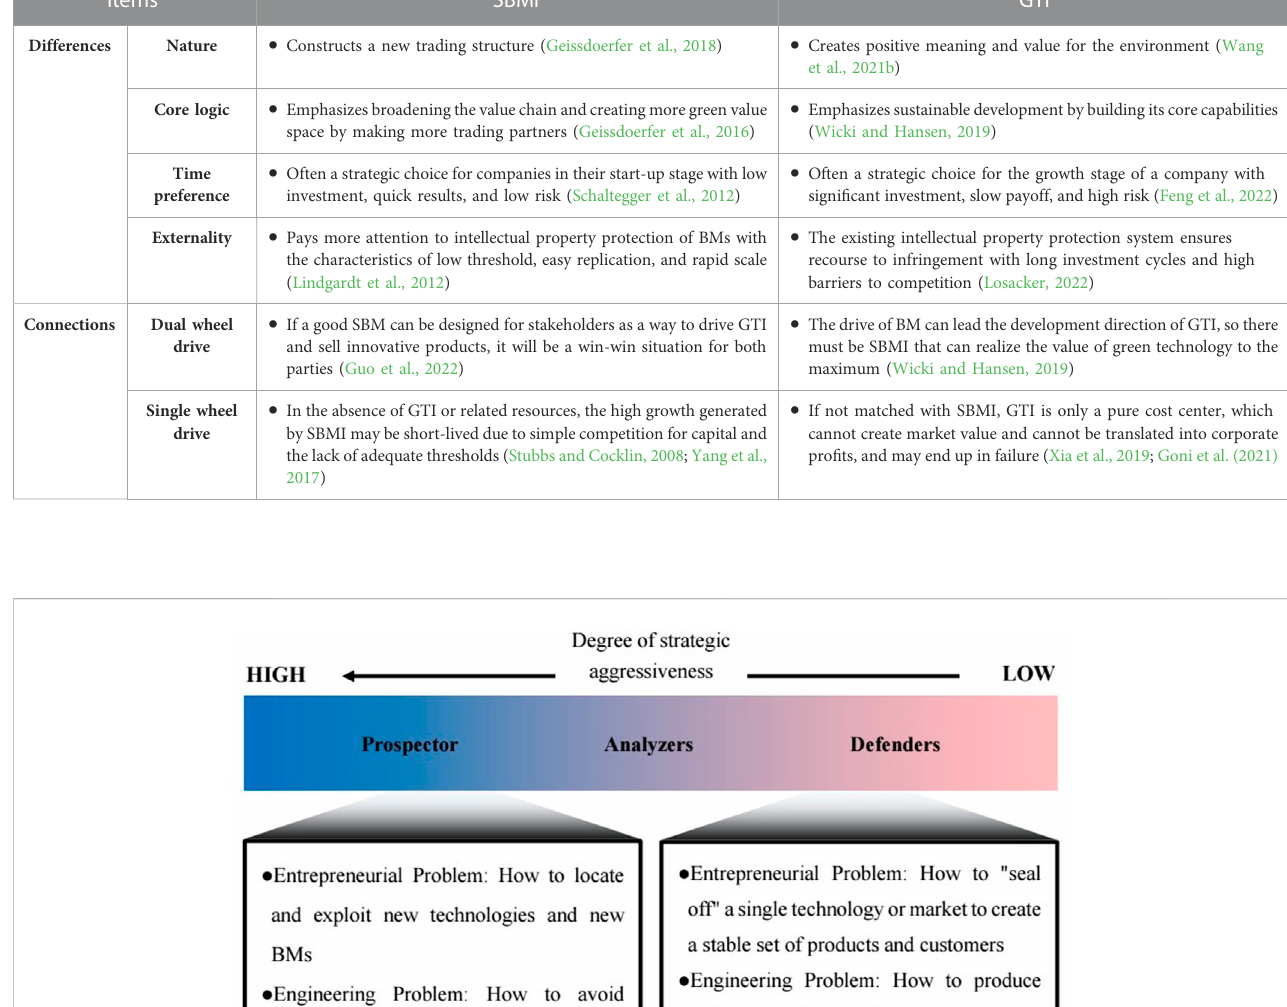
TABLE 1 Differences and connections between SBMI and GTI. Items